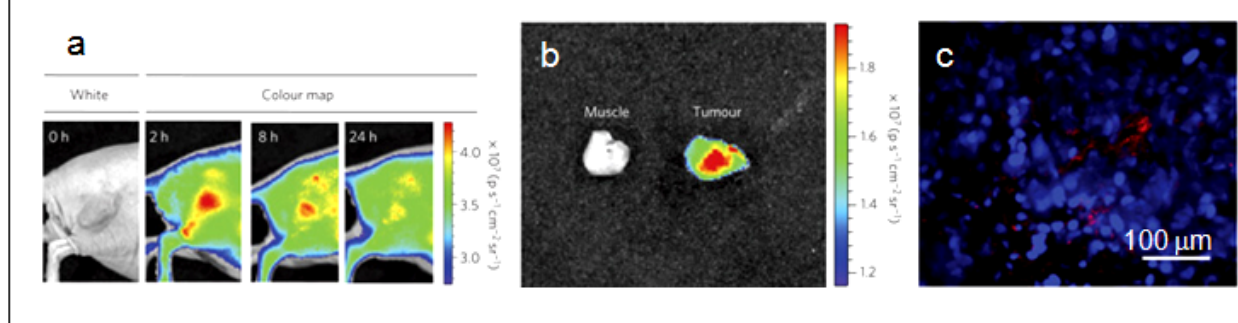
Figure 6. ( a ) Representative fluorescence images of a mouse with an MDA-MB-435 tumor. The mouse was imaged using a 615–665 nm excitation filter and an 810–875 nm emission filter at the indicated time post-intravenous injection of D-LPSiNPs (20 mg/kg). A strong signal from D-LPSiNPs is observed in the tumor, indicating significant passive accumulation in the tumor by the enhanced permeability and retention (EPR) effect. ( b ) Ex vivo fluorescence images of the tumor from the mouse used in (a). ( c ) Fluorescence images of a tumor slice from the mouse in (a). Red and blue indicate D-LPSiNPs and cell nuclei (DAPI stain). (Reprinted with permission from [99], copyright 2009